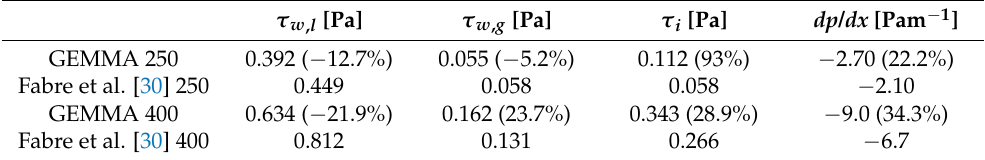
Table 2. Pressure drop and wall and interfacial shear stresses from the CFD simulations and the experiments of Fabre et al. [30], with percentage relative errors from GEMMA in